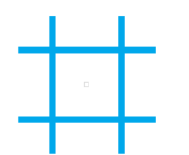
Figure 5. The symbol of the water